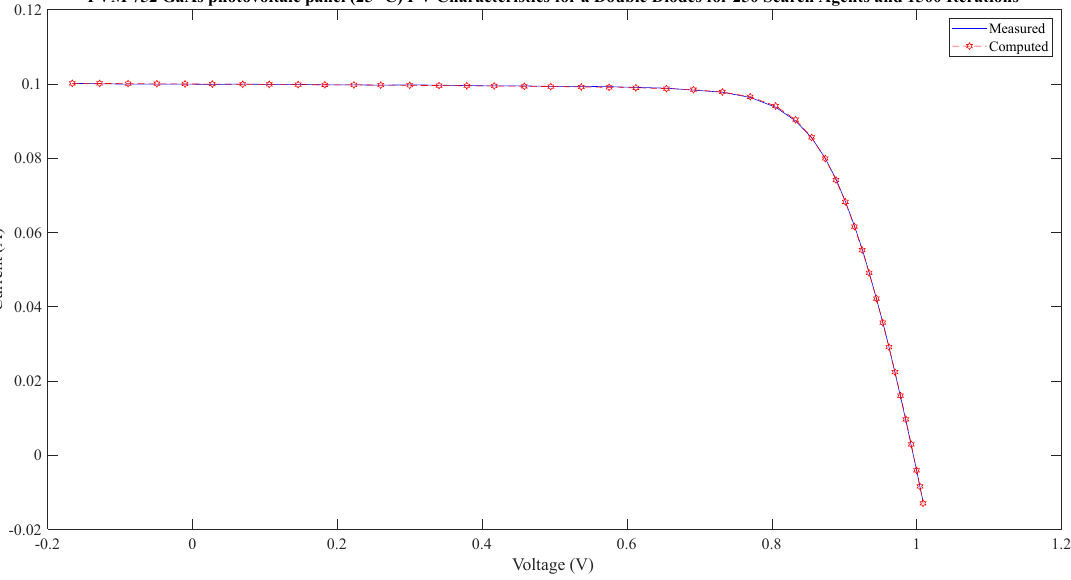
Figure 10. The current-voltage characteristics of PVM 752 GaAs photovoltaic panel for double diodes (DDM).